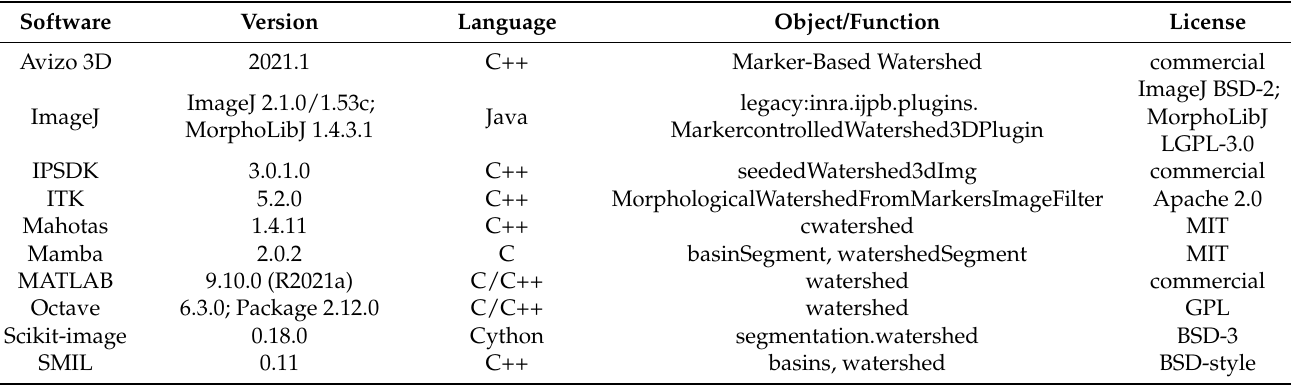
Table 1. Watershed implementations under the